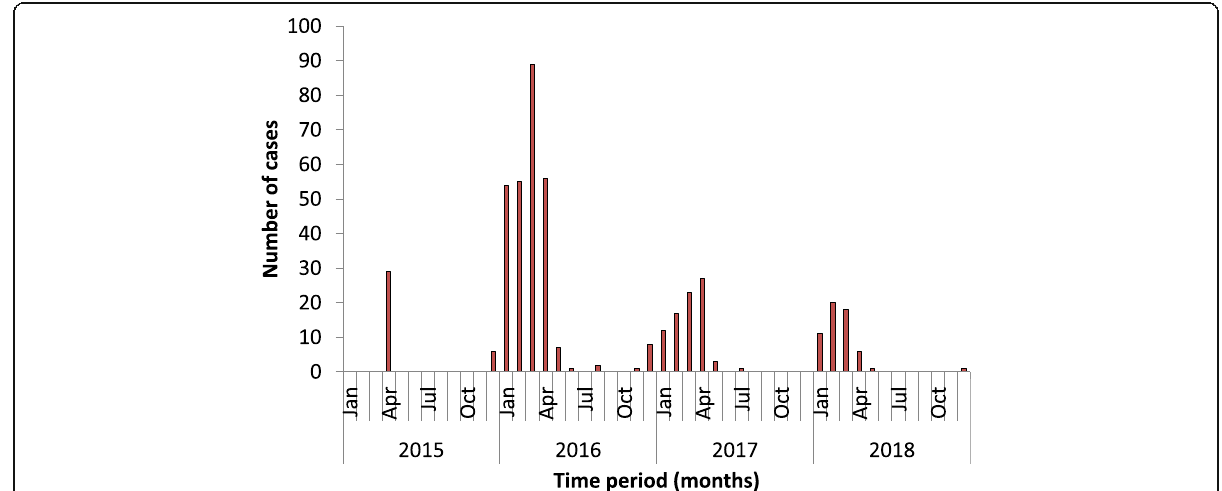
Fig. 3 Bar chart showing the seasonality of Kyasanur Forest Disease cases in the state of Goa, India, during 2015 – 2018